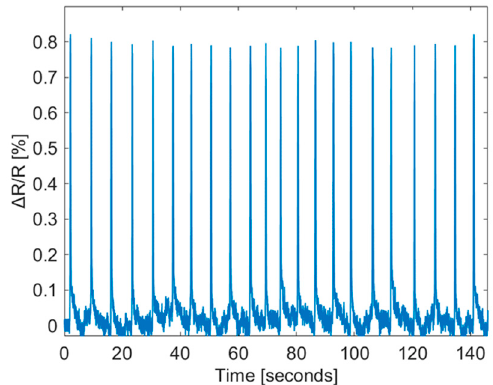
Figure 10. The normalized sensor resistance changes in repeated cycles of loading/unloading at